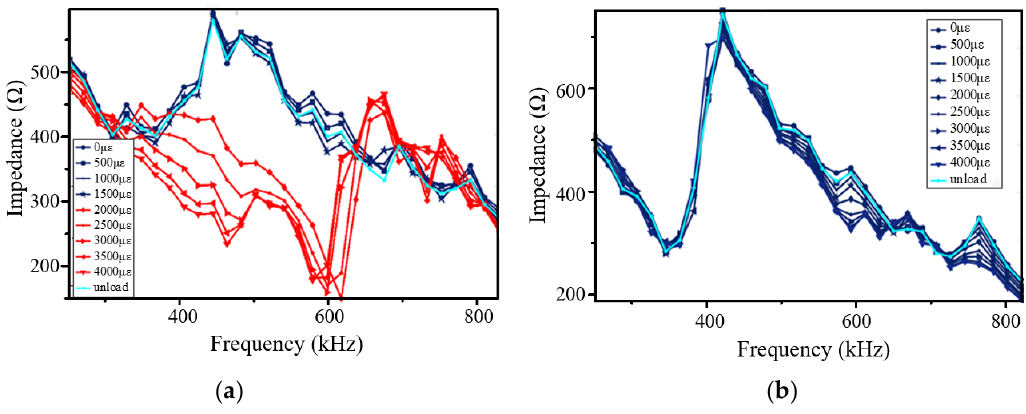
Figure 13. The impedance of PZT under different strain conditions at the adhesive (Hysol EA 9395) thickness ( a ) 25 μm and ( b ) 125 μm.